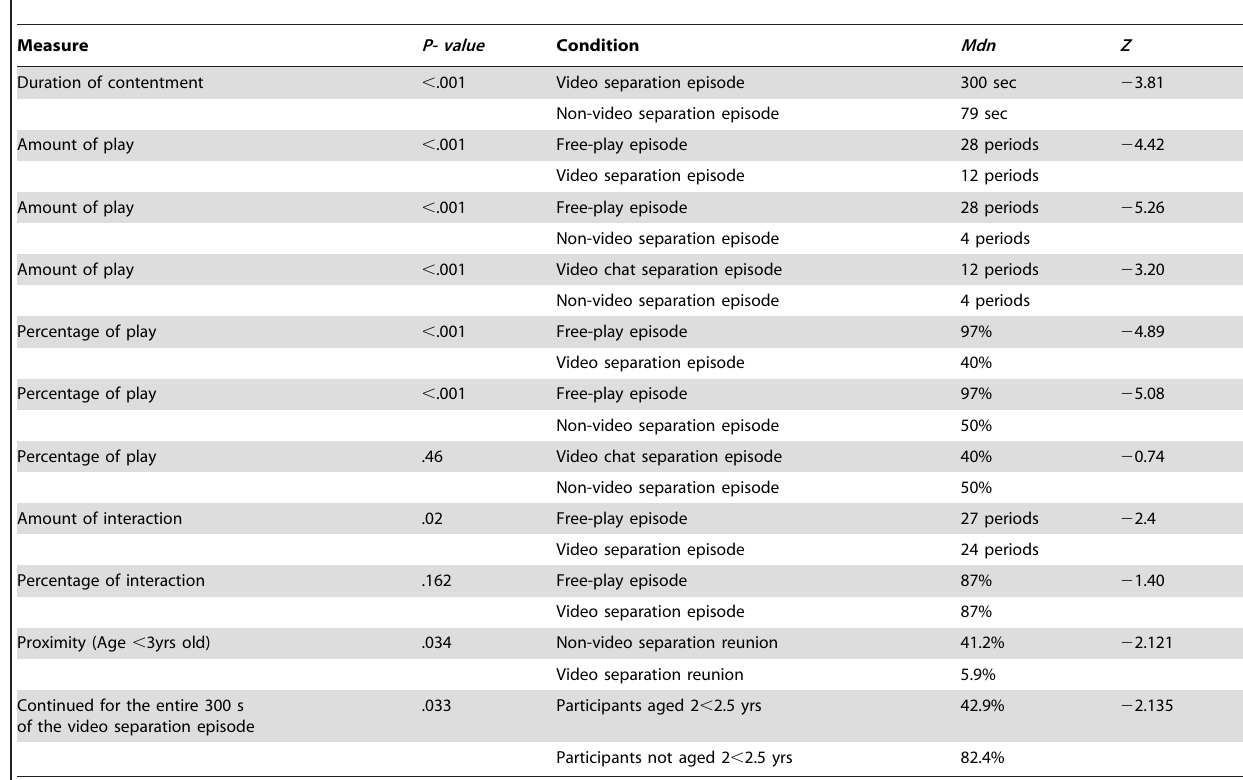
Table 1. Medians of the Behavioral Indicators for Each Episode and Results of Wilcoxon Signed Rank Tests used to compare Behaviors across